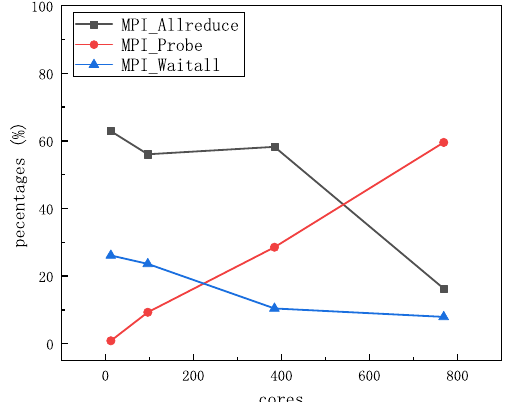
Figure 5. Percentages of key Message Passing Interface (MPI) communication. The test case and its working condition are the same as that in Figure 4. We do not present the trivial MPI communication in this